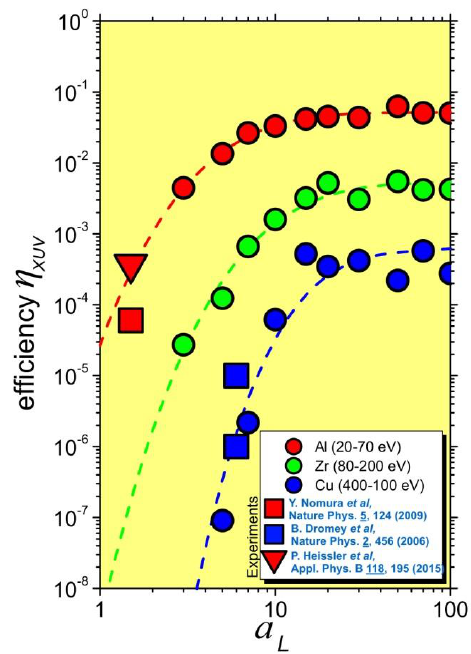
Figure 4. Variation of the XUV pulse efficiency η XUV with the normalized vector potential a L for three different spectral ranges determined by the indicated thin filter used. Part of the figure from Ref. [87].